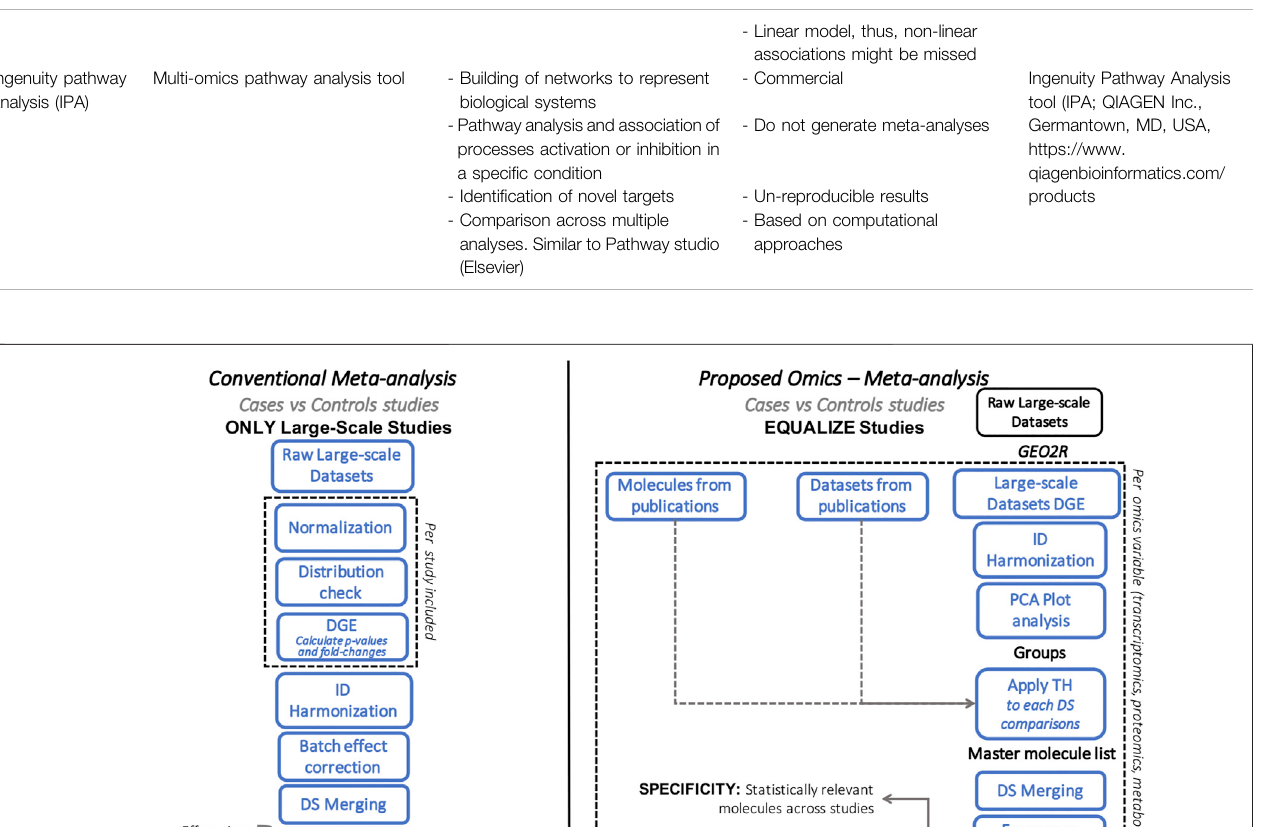
Frontiers in Genetics |